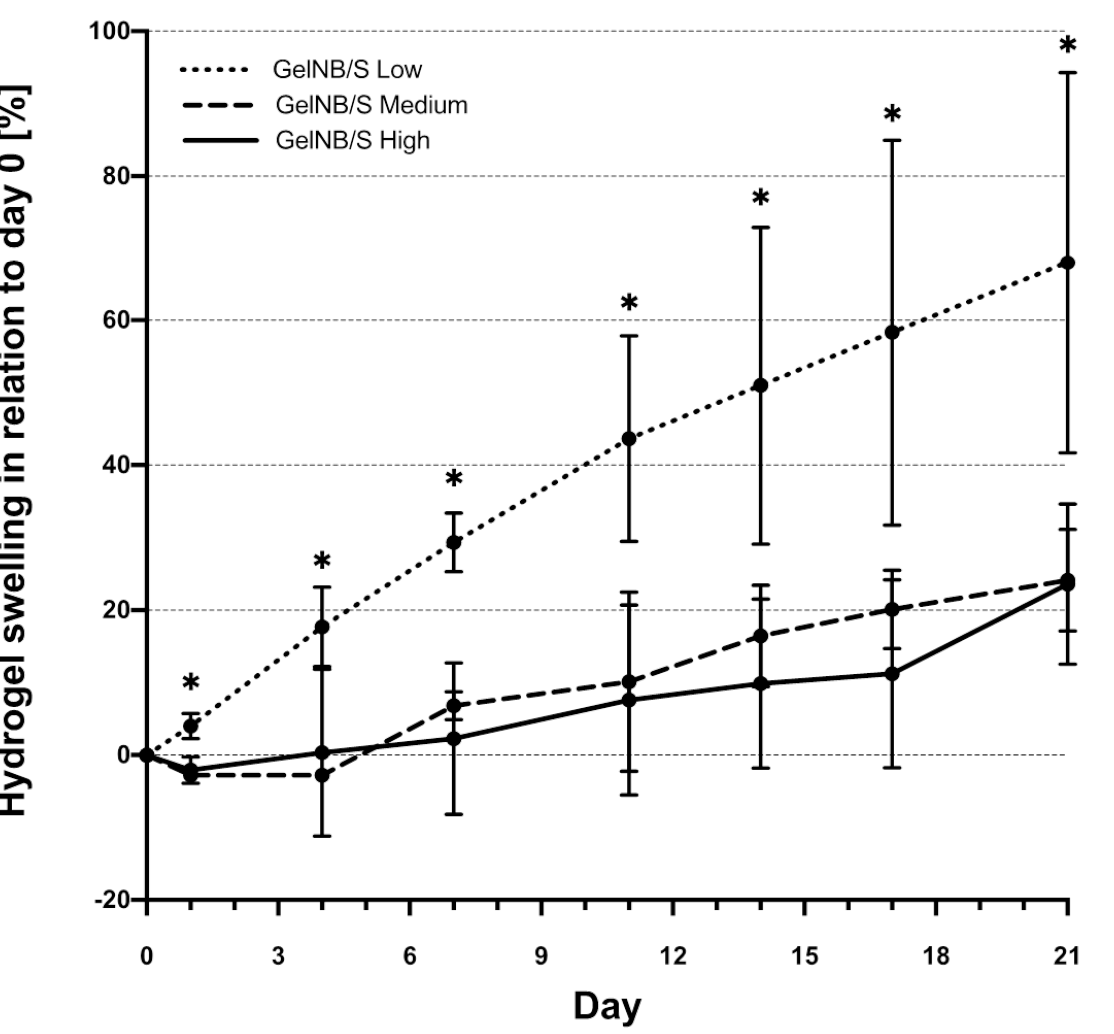
Figure 4. Swelling or degradation properties of GelNB/GelS-low, GelNB/GelS-medium and GelNB/GelS-high hydrogels. Hydrogels at different concentrations were plated in triplicate in tissue culture dishes and after gelation were overlaid with growth medium. The weights of the gels after the removal of the growth medium was determined at days 0, 1, 4, 7, 11, 14, 17 and 21. Swelling is indicated by an increase in weight, whereas degradation of the hydrogels is indicated by a decrease in weight. Values at the respective days were normalized to day 0 and are expressed as percent swelling values in relation to day 0. Shown are means ± SD (n = 3). Asterisks indicate statistically significant differences between the groups in relation to GelNB/GelS-high (* p < 0.05).